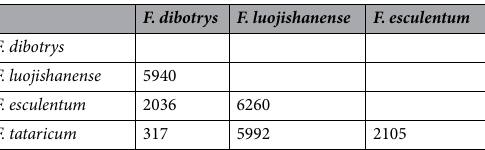
Table 3. Numbers of nucleotide substitutions in four complete chloroplast